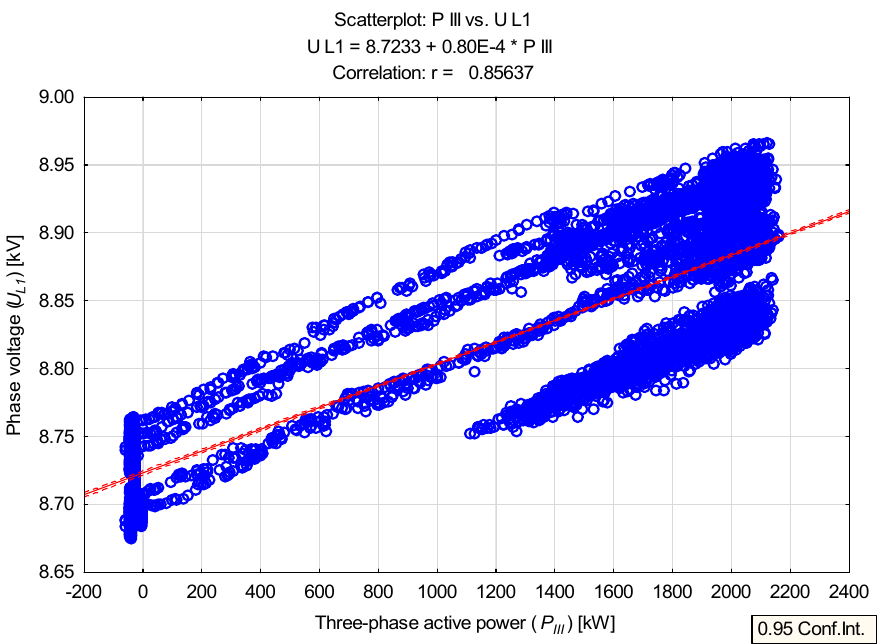
Figure 10. Diagram of the dependence of the value of phase voltage ( U L 1 ) at the connection point on three-phase active power ( P III ) generated by the wind power plant.